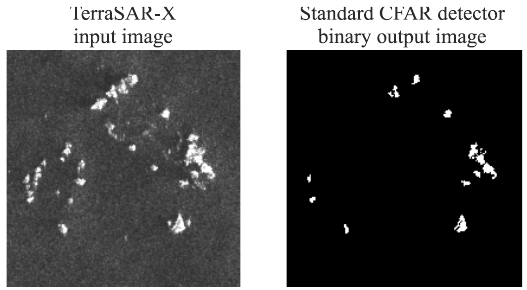
Figure 3. Standard CFAR detector applied to a section of a TerraSAR-X image with high iceberg